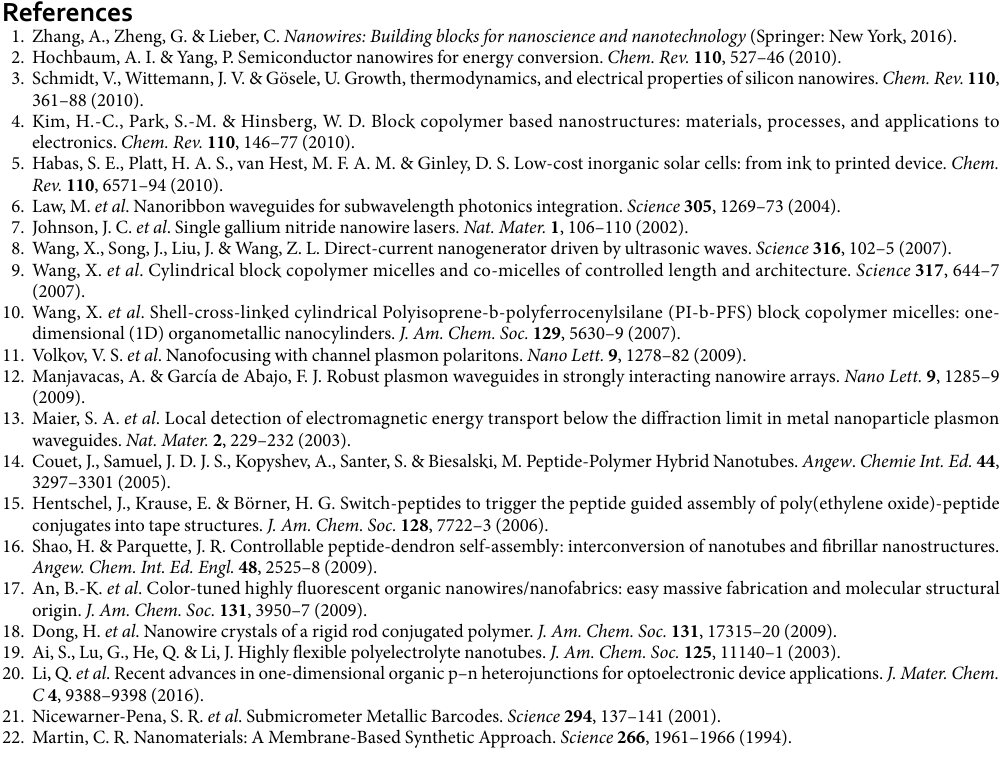
8 SCIEntIfIC REPORtS | 7: 8506 | DOI:10.1038/s41598-017-08153-0